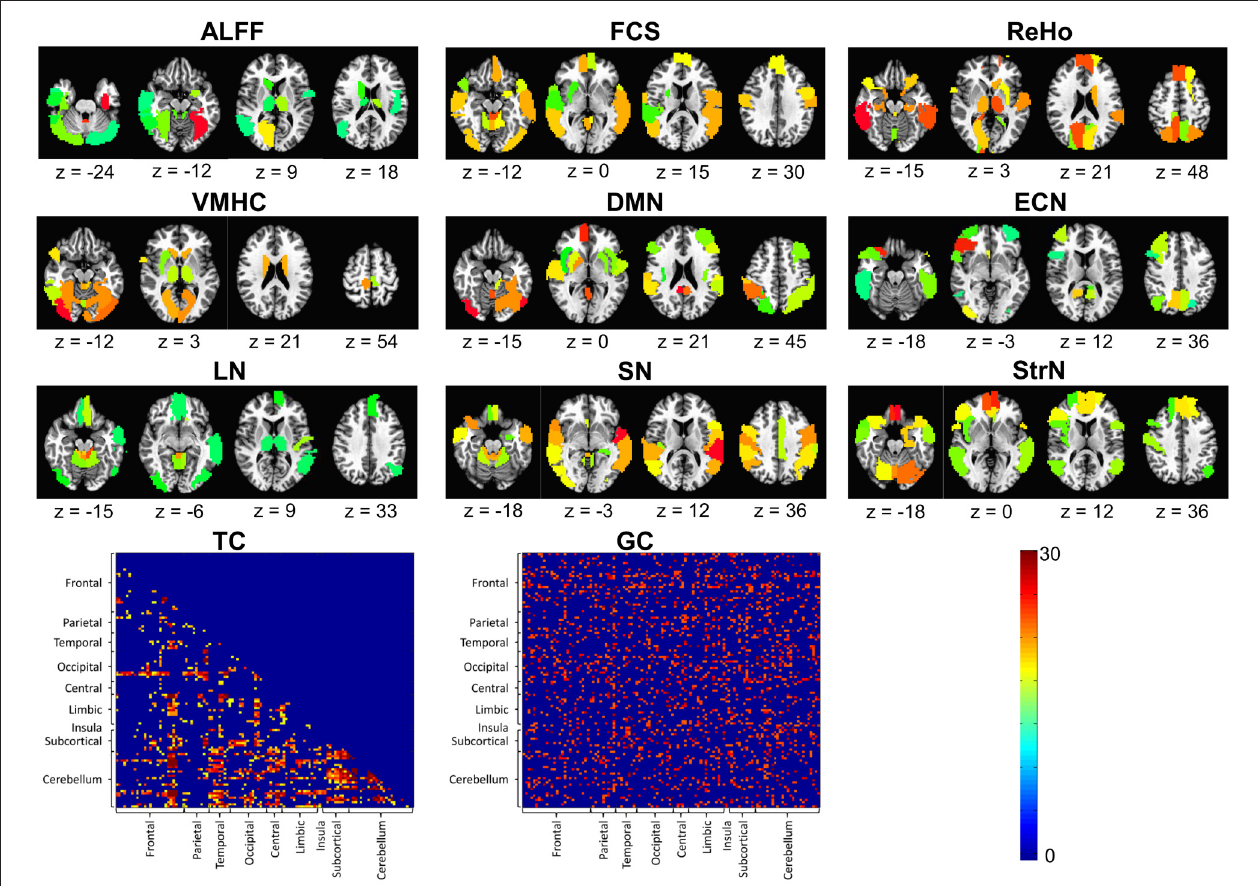
FIGURE 5 | Significant feature maps for each of the applied resting state features: amplitude of low frequency fluctuations (ALFF), functional connectivity strength (FCS), regional homogeneity (ReHo), voxel-mirrored homotopic connectivity (VMHC), default-mode network (DMN), executive-control network (ECN), limbic network (LN), salience network (SN), striatum network (StrN), temporal correlation (TC), and Granger causality (GC). The color bar denotes the number of times that an ROI was selected in 10-fold cross-validation in the three combination frameworks ( p <